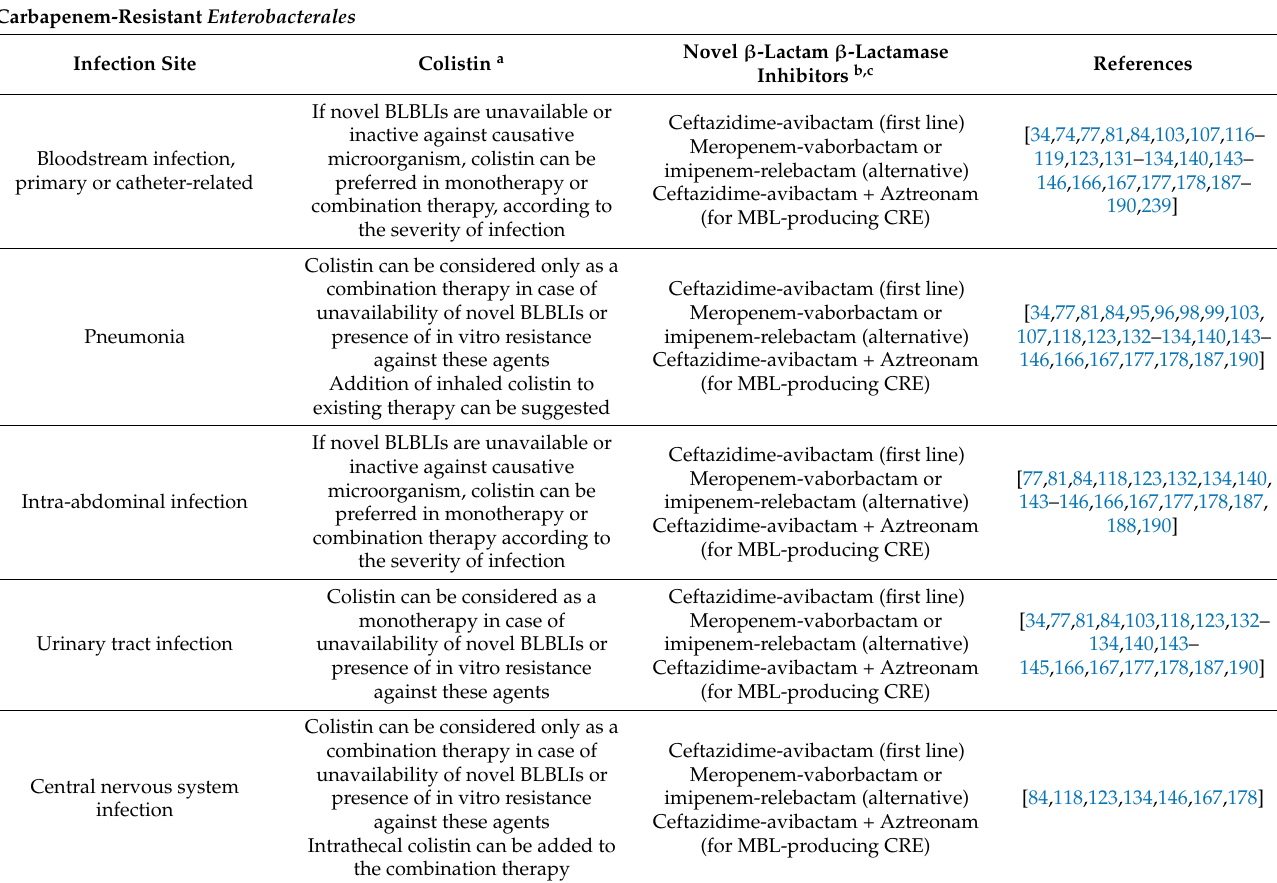
Table 2. Colistin vs. novel β -lactam β -lactamase inhibitors for the treatment of CR-GNB infections, according to infection